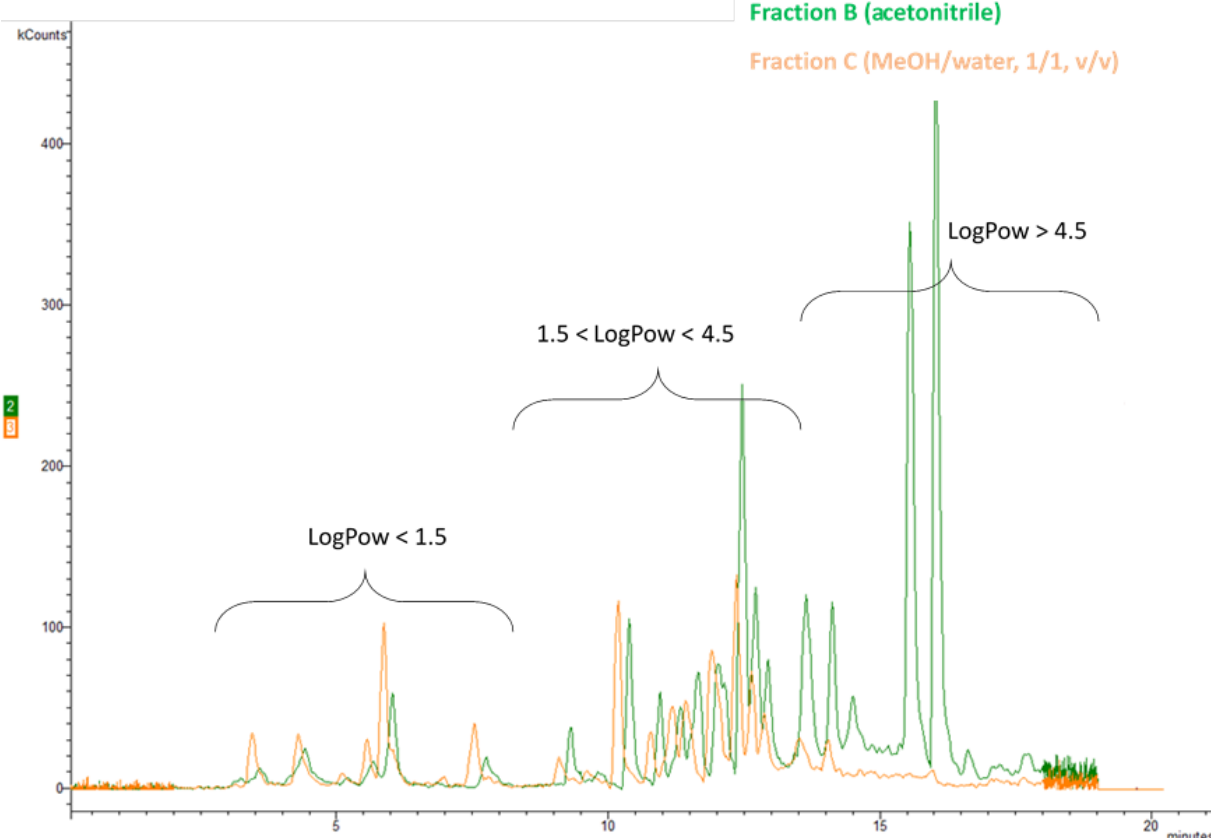
Figure 4. Comparison of TIC chromatograms of Fraction B (green line) and of Fraction C (orange line) of a sludge sample fortified with all the analytes at 10 ng/g and internal standard at 100 ng/g.